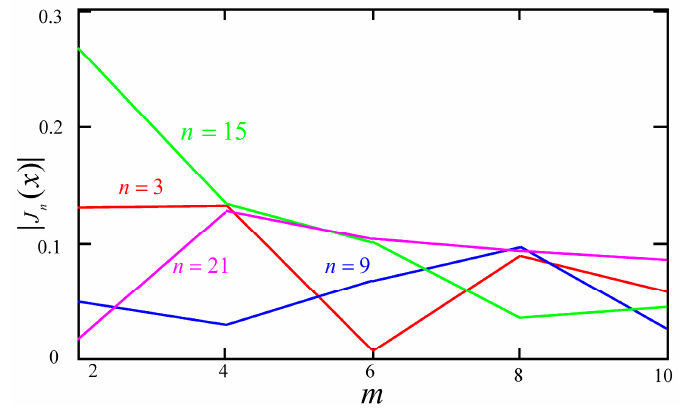
Figure 6. Relationship between the amplitude of CMV harmonics and its order.